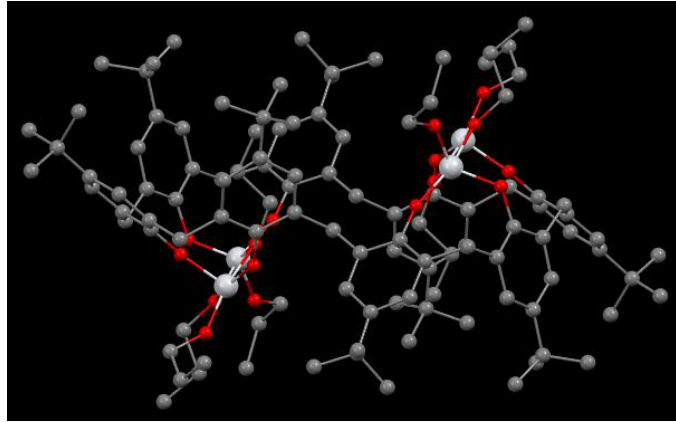
Figure 20. Molecular structure of 60 [42].